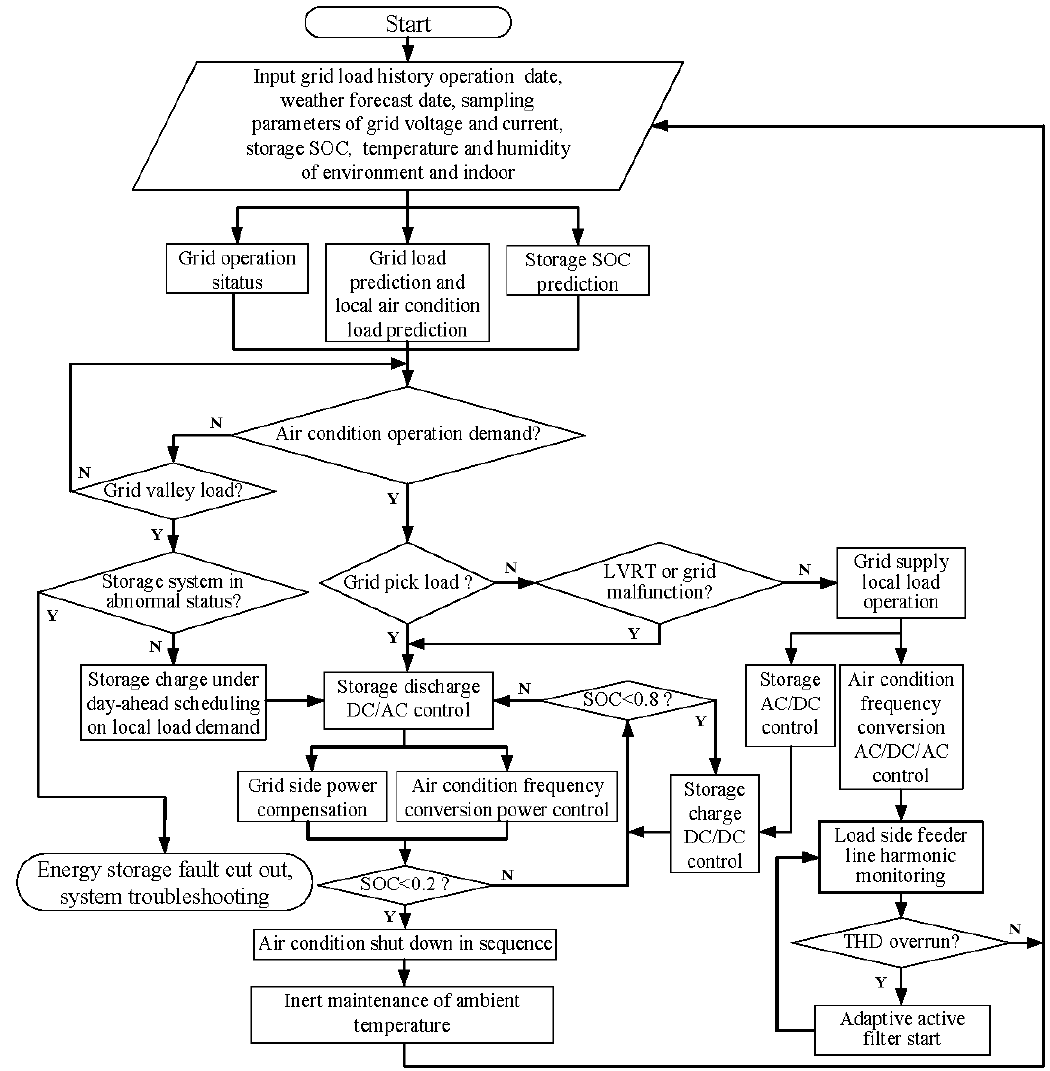
Figure 8. Active demand management of group load operation coordination control flow chart.